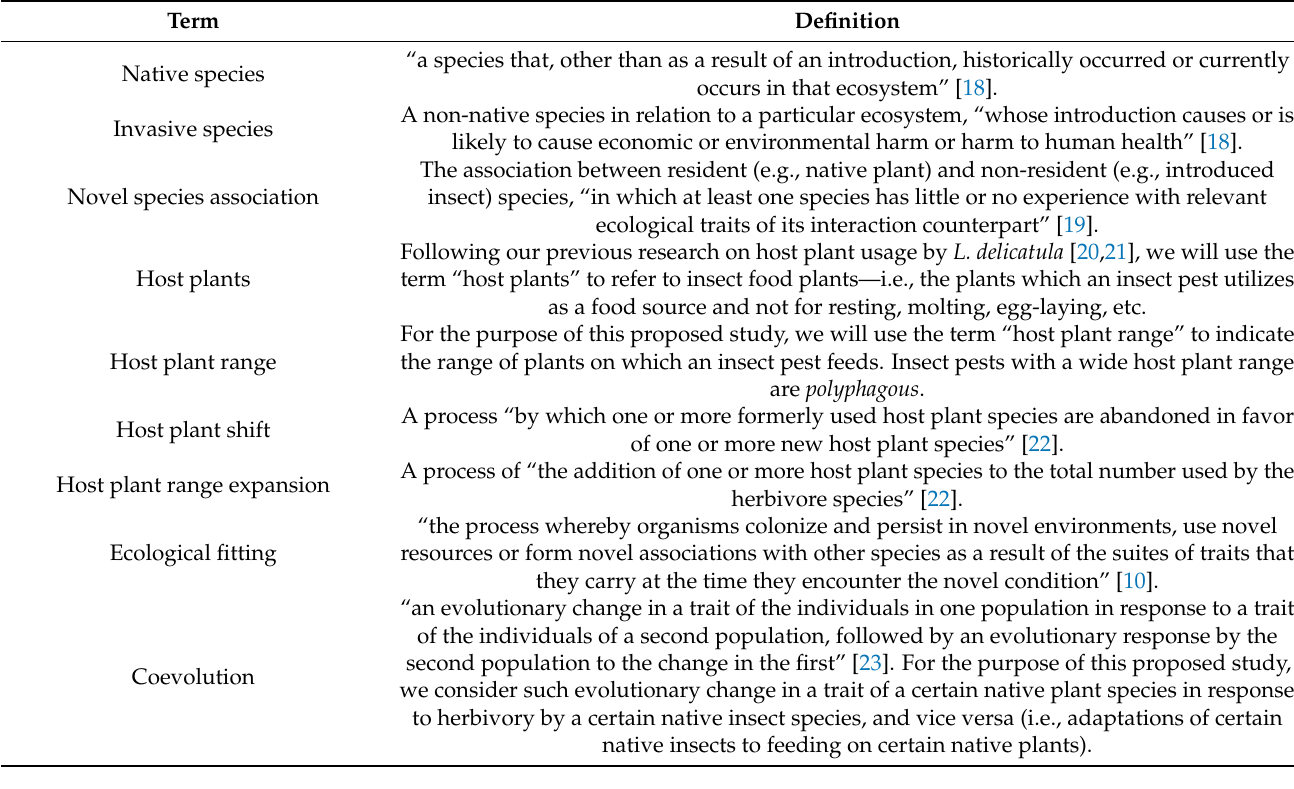
Table 1. Terminology in the context of the